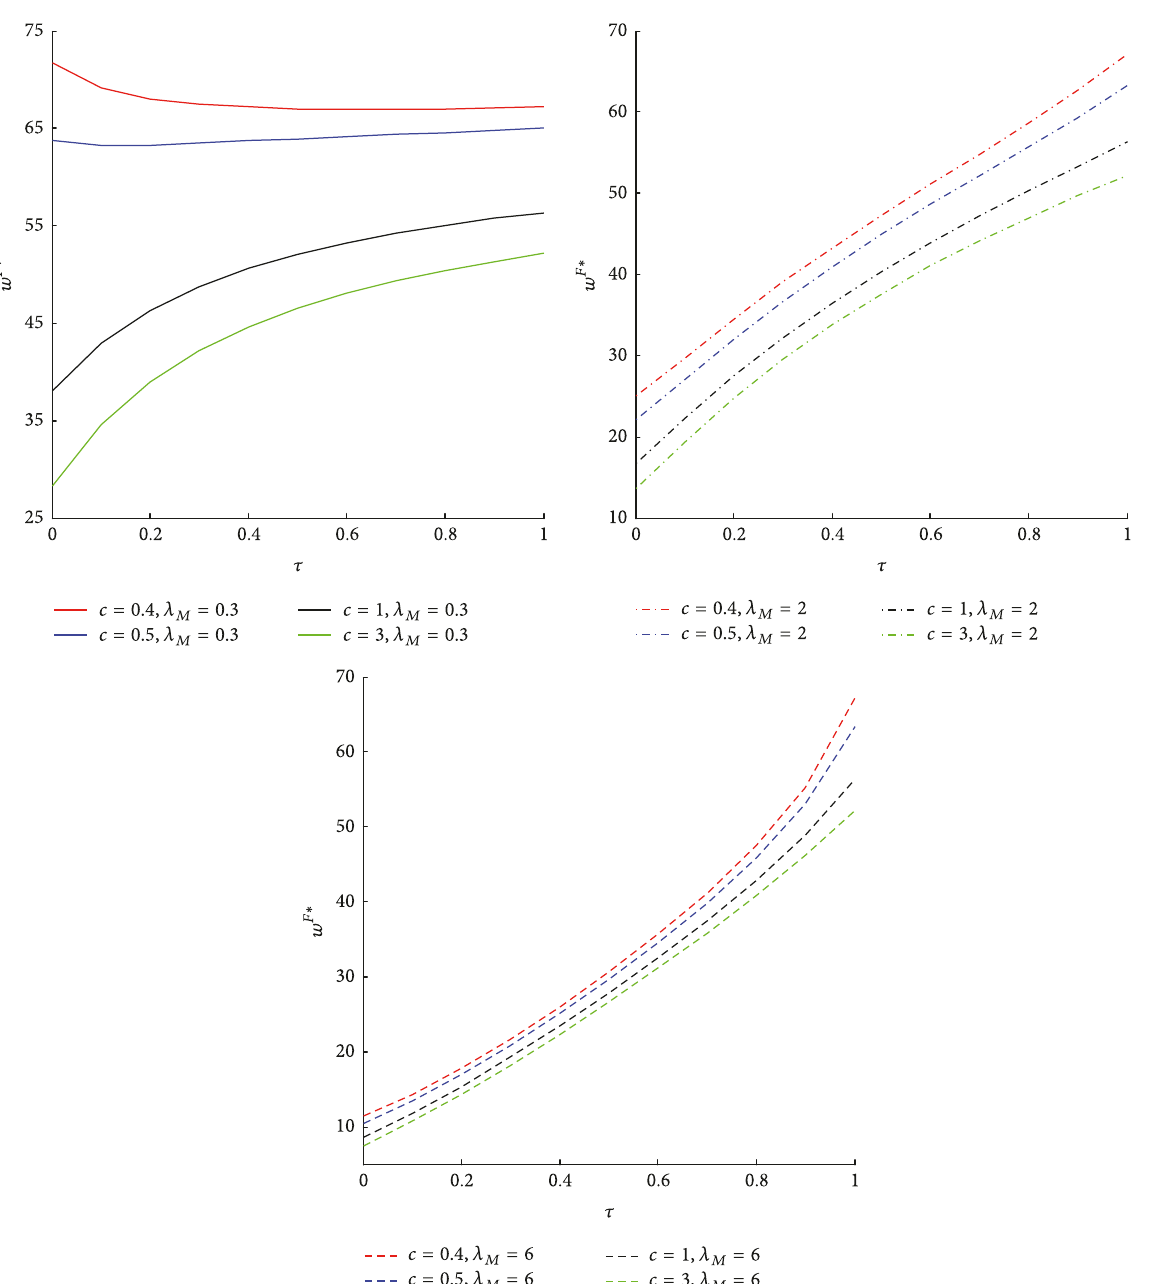
Figure 3: Effects of 𝜏 on the equilibrium wholesale price (𝑎 = 600 , 𝛼 = 8 , 𝛽 = 10 , V 𝑆 = 3 , V 𝑀 = 2 , 𝜆 𝑆 = 5 , 𝜀 = 0.4) .